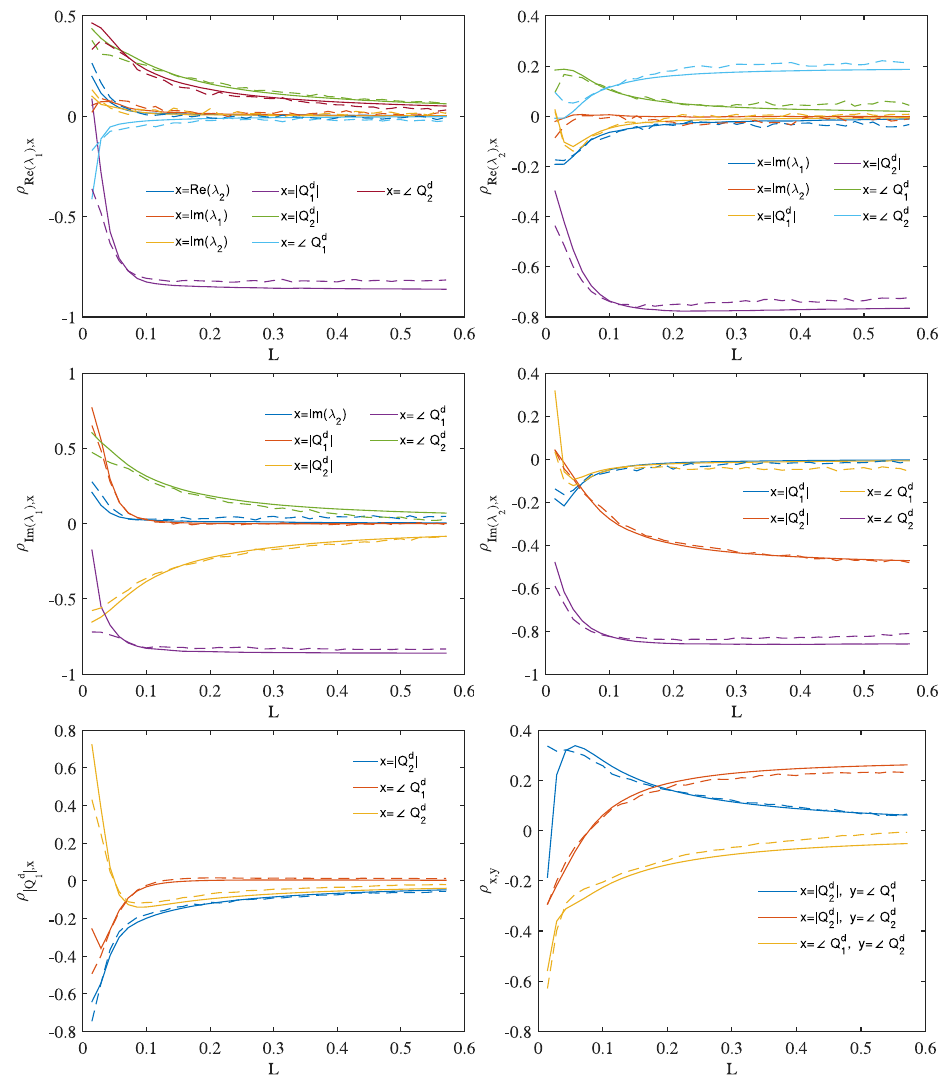
Figure 3. Noise linear addition approximation for the pulse with (cid:31) 1,2 = ( 6 j , 1 + 5 j ) and Q d 1,2 = ( − 6 j , − 2 j ) . Solid curves: model predictions, dashed curves: pulse propagation